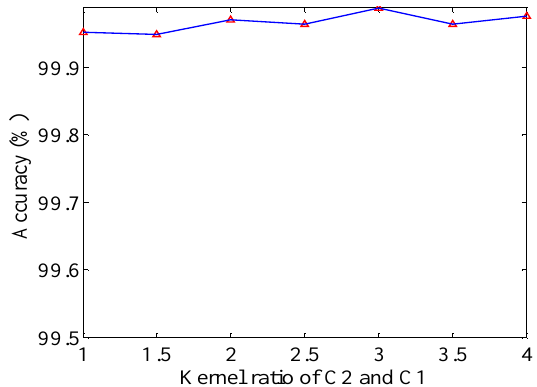
Figure 18. Classification accuracy by different kernel number. Table 2. Computational time of different kernel numbers in one epoch.